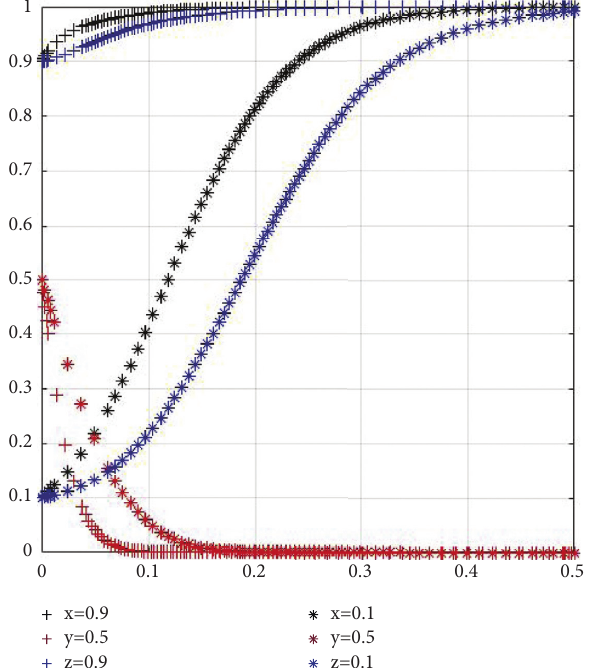
Figure 8: The government chooses to supervise the changes in the revenue of the strategy ( P 1 � 15 ⟶ P 1 � 30 ⟶ P 1 �